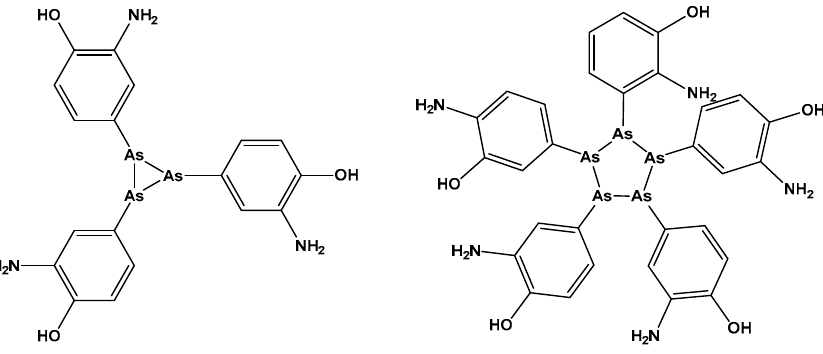
Figure 2. Chemical structures representing the composition of the mixture known as Salvarsan ® .